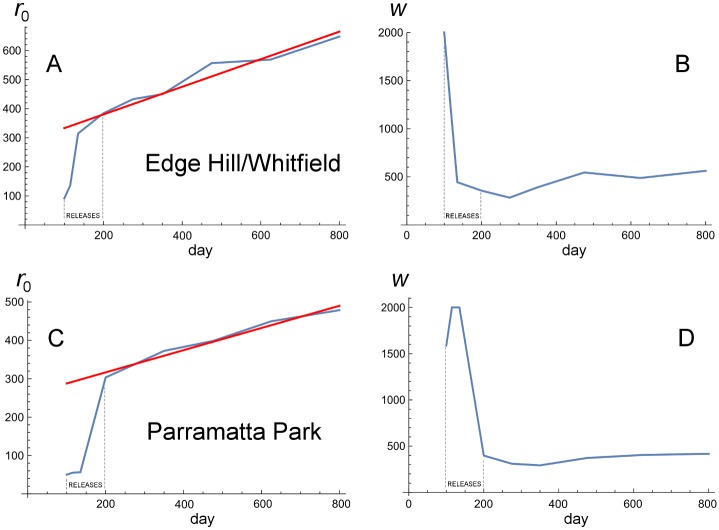
Estimating rates of spatial spread and wave width for Edge Hill/Whitfield (EHW) and Parramatta Park (PP).Panels A and B plot the estimates of r0 and w (from S2 Table) through time for EHW; panels C and D show the estimates for PP. The x axis in each panel represents days; the releases began on day 99 and ended on day 197. The slopes of the fitted regression lines imply wave speeds of cd = 0.474 m per day at EHW and cd = 0.289 m per day at PP. See the text for discussion and interpretation.